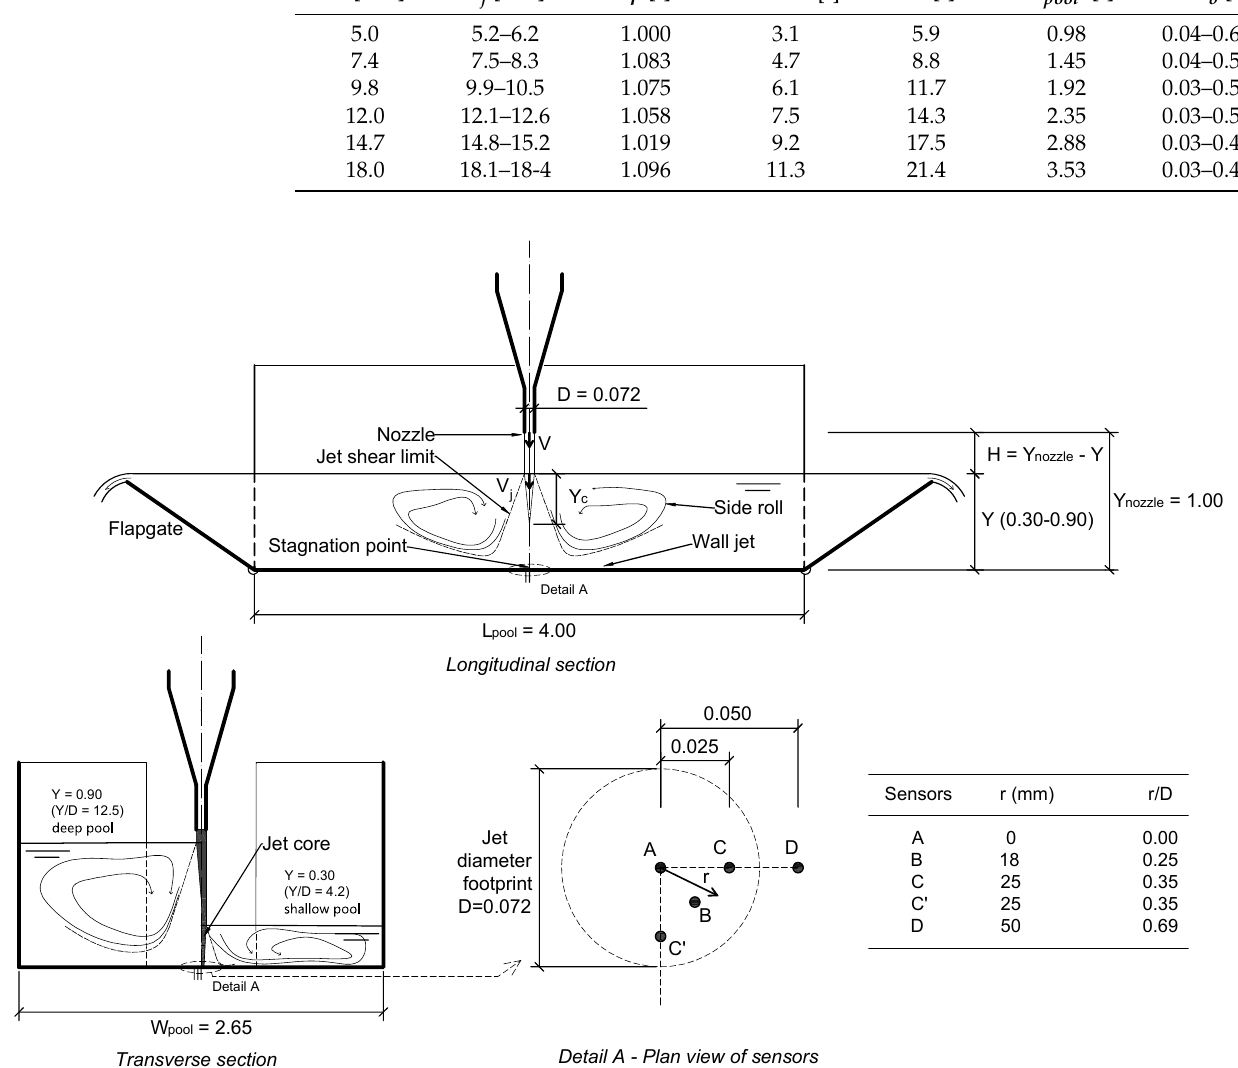
Figure 2. Scheme of the experimental facility— Dimensions in meters